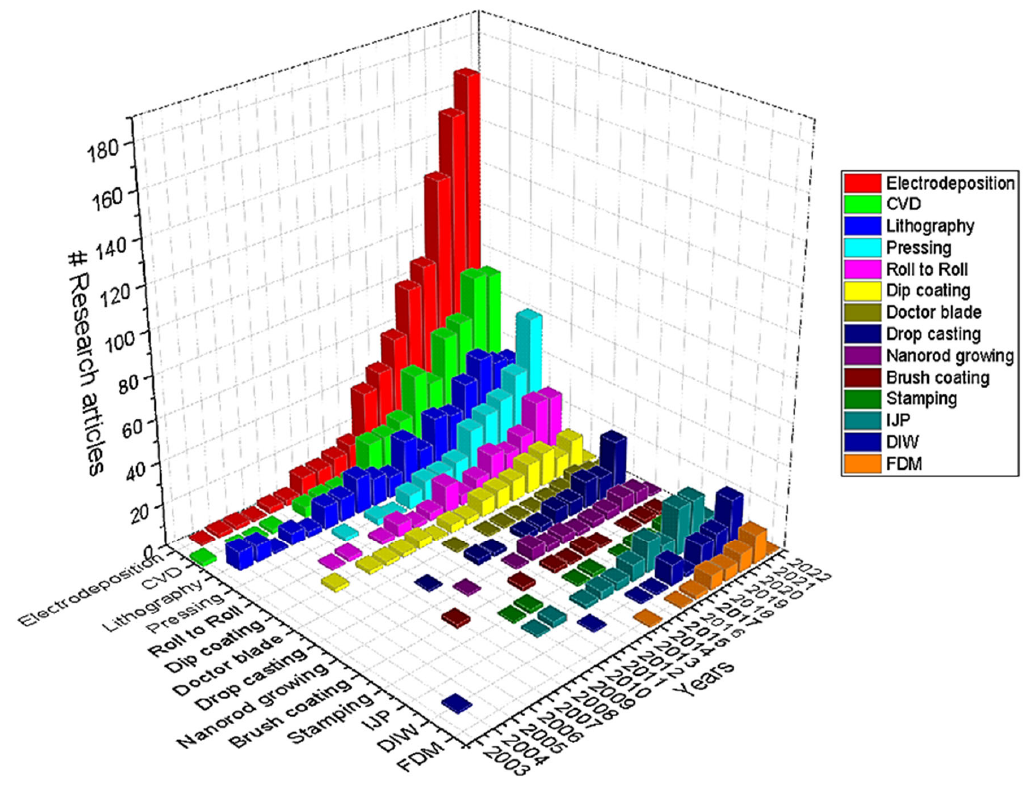
Figure 5. The number of research articles vs. years for di ff erent electrode fabrication techniques